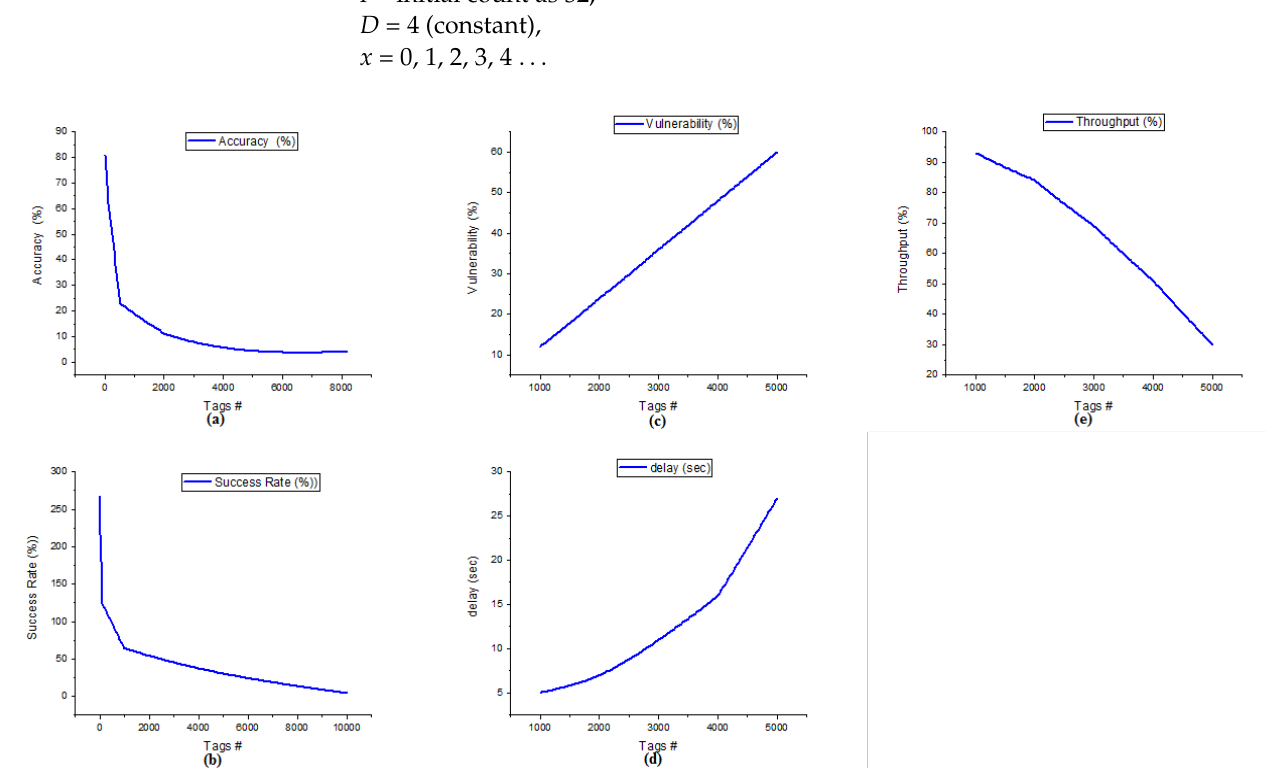
Figure 2. ( a ) Accuracy of AOMDV_SAPTV ( b ) Success rate of AOMDV_SAPTV ( c ) Vulnerability of AOMDV_SAPTV ( d ) Delay of AOMDV_SAPTV ( e ) Throughput of AOMDV_SAPTV. AOMDV_SAPTV ( d ) Delay of AOMDV_SAPTV ( e ) Throughput of